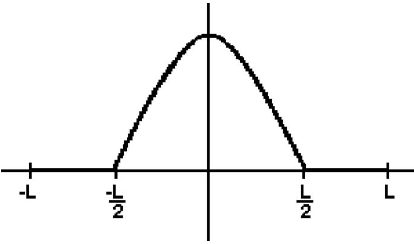
FIG. 4. Wave function of the electron in the